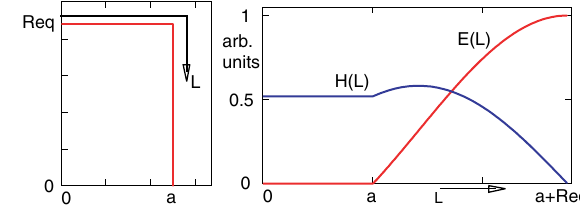
FIG. 7. Geometry: a pillbox half-cell with length a , and fields on its